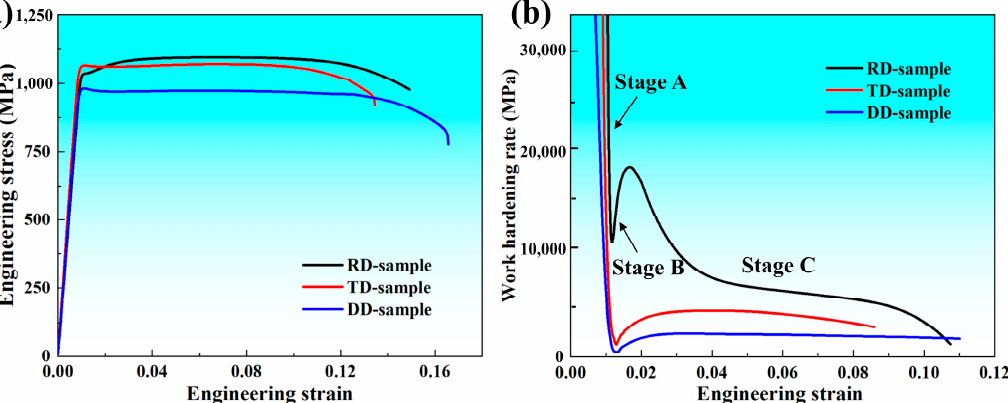
Figure 2. Initial microstructure of the Ti-6Al-4V. ( a ) Phase distribution map (Green for α and red for β phase). ( b ) EBSD inverse pole figure (IPF). ( c ) Grain size distribution map of the α phase. ( d ) {0001} pole figure (PF).